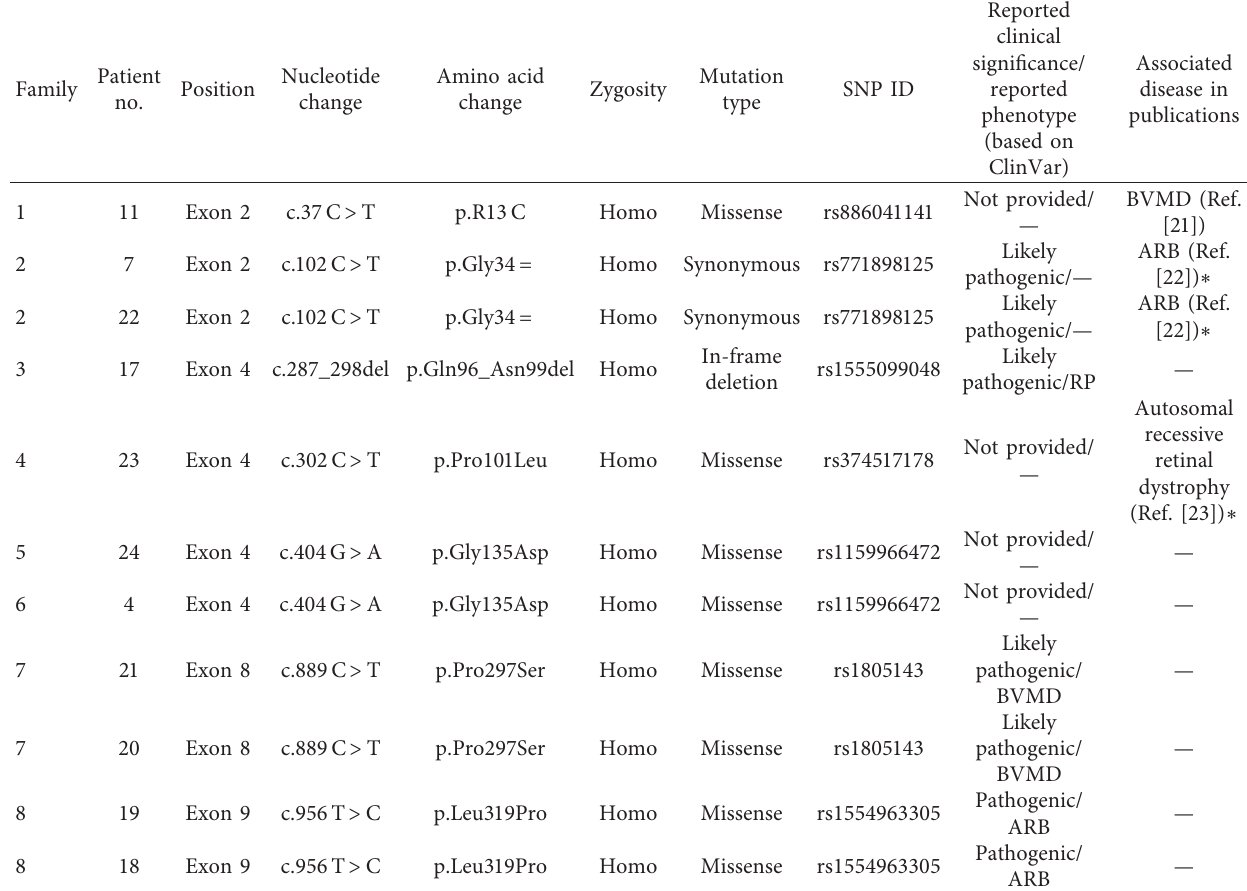
Table 1: BEST1 mutations of genetic testing results.